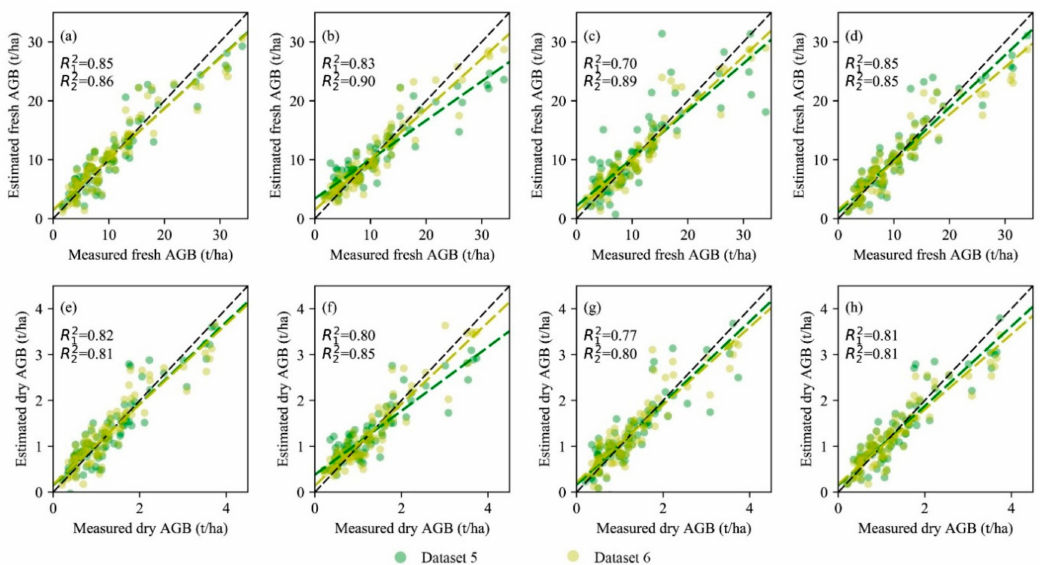
Figure 10. Comparisons of measured AGB and estimated AGB of maize via the four methods based on Dataset 5 (green spots) and Dataset 6 (yellow spots), which were derived from the LiDAR point clouds: ( a – d ) OLS, RF, BP, and SVM for the AGB estimation of fresh maize; ( e – h ) OLS, RF, BP, and SVM for the AGB estimation of dry maize. R 12 and R 22 represent the coe ffi cient of determination for a linear regression model between the measured and estimated AGB using Datasets 5 and 6,